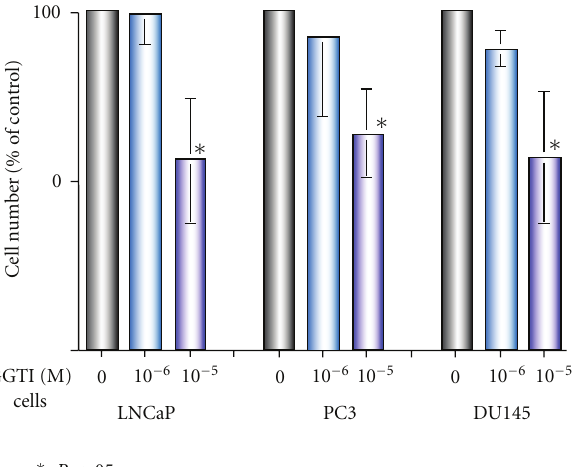
Figure 3: Growth inhibitory e ff ect of GGTI. Cells were incubated in 1 μ M–10 μ M of GGTI for 72 h, and the subsequent cell growth was determined. The cell number counted in the vehicle control was defined as being equal to